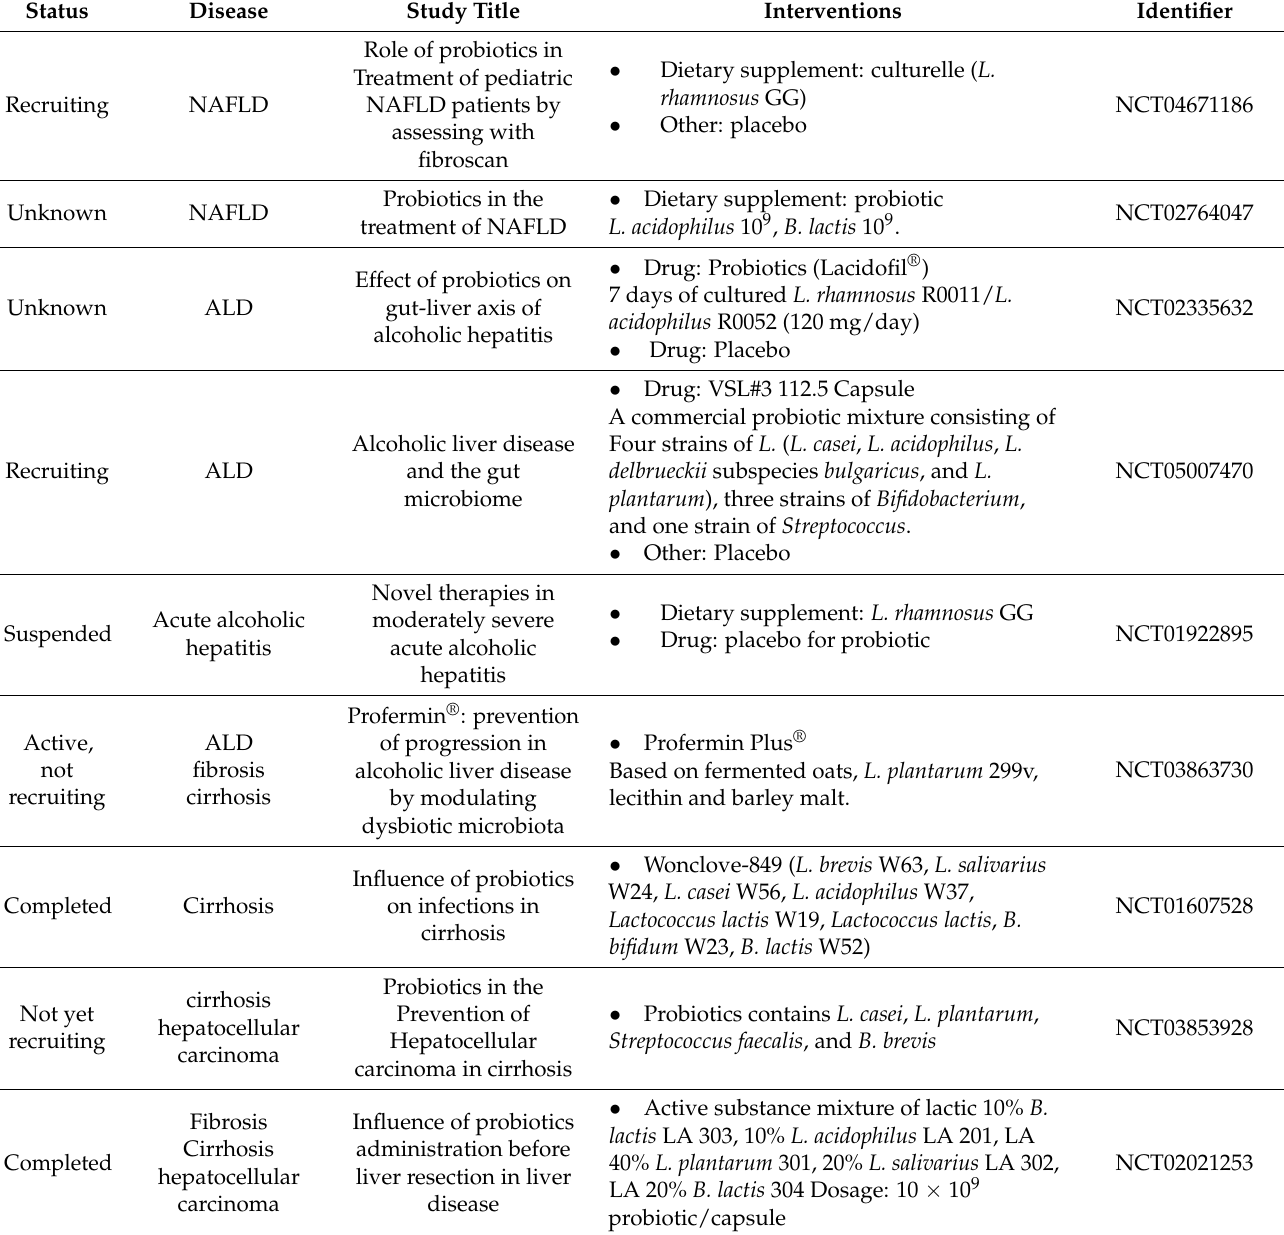
Table 3. Clinical trials currently in progress with Lactobacillus